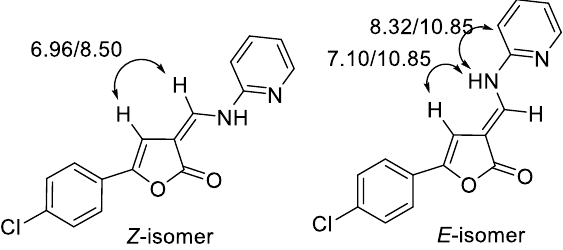
Figure 3. Key NOE-contacts for Z - and E -5-(4-chlorophenyl)-3-(pyridin-2-ylamino)methylidenefuran-2(3 H )-one 9a .